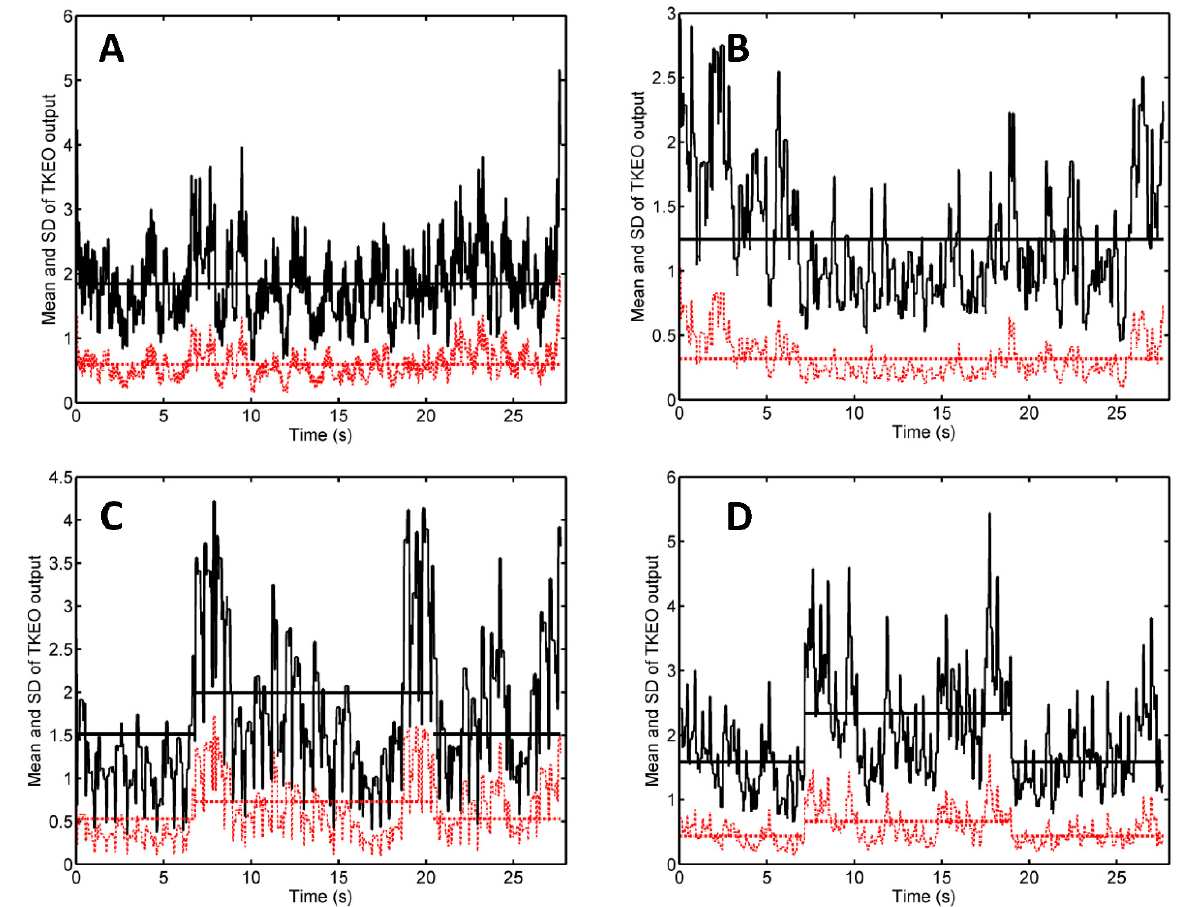
Figure 2. Teager-Kaiser energy operator (TKEO) analysis of the M-mode US scans shown in Figure 1. Panels ( A – D ) correspond to the respective panels of Figure 1. Portions of the M-mode US scans corresponding to the depth range of 2–6 cm have been cropped, converted to grayscale, and the resulting pixel values were transformed via the TKEO operator. At any instant of time, the mean value and standard deviation (SD) of the TKEO output were computed and plotted as a red dashed line and black solid line, respectively.